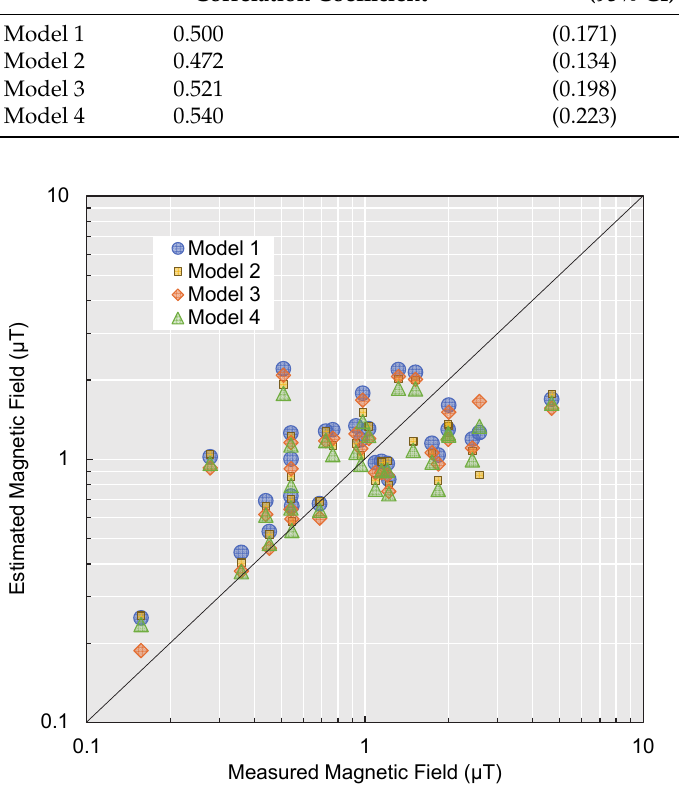
Figure 5. Comparison of magnetic field estimated from questionnaire responses and actual measured magnetic field. The closer the plot is to the black shaded line in this figure, the more accurate the estimation.